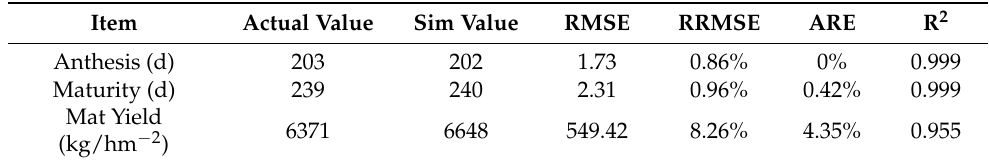
Table 7. Simulation effects of the Xinji city winter wheat validation period based on DSSAT